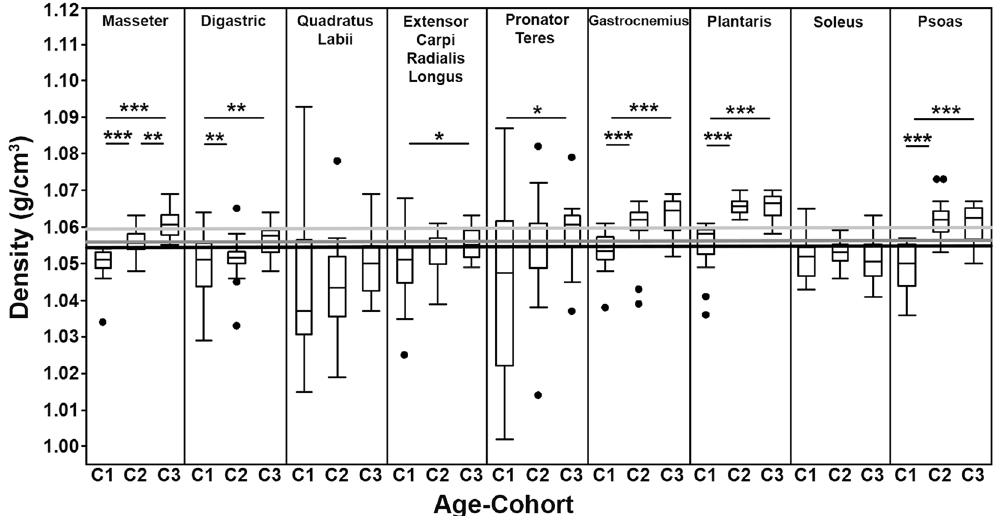
Figure 2. The distributions for the density of each muscle per each of the three cohorts: C1 = 3 weeks; C2 = 8 months; C3 = 2 years old. The lines above the box plots indicate significant differences between connected columns (* p < 0.05, ** p < 0.01, *** p < 0.0001) for each muscle. The light gray and medium gray lines depict the constants taken from Mendez and Keys (1.0597 g/cm 3 ; 1960) and Murphy and Beardsley (1.0564 g/cm 3 ; 1974) respectively. The black line represents the grand mean of all the muscles measured in this study (1.0546 g/cm 3